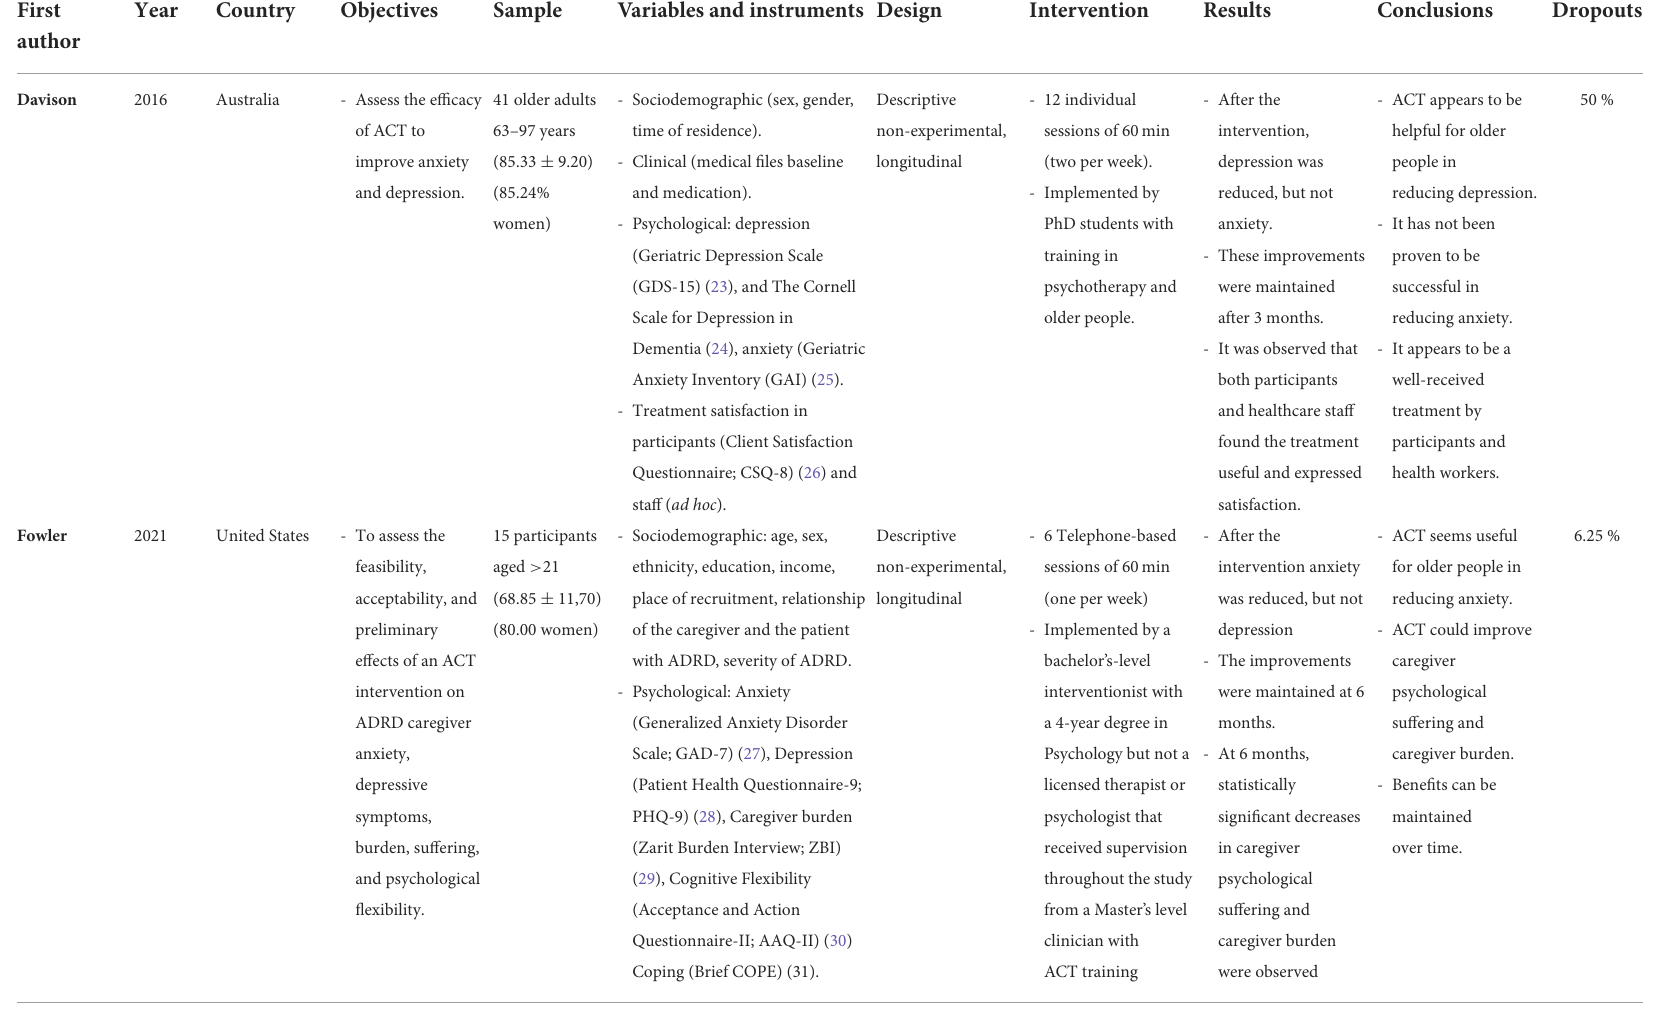
TABLE 1 Characteristics of studies included in the systematic review ( N = 7) and article quality